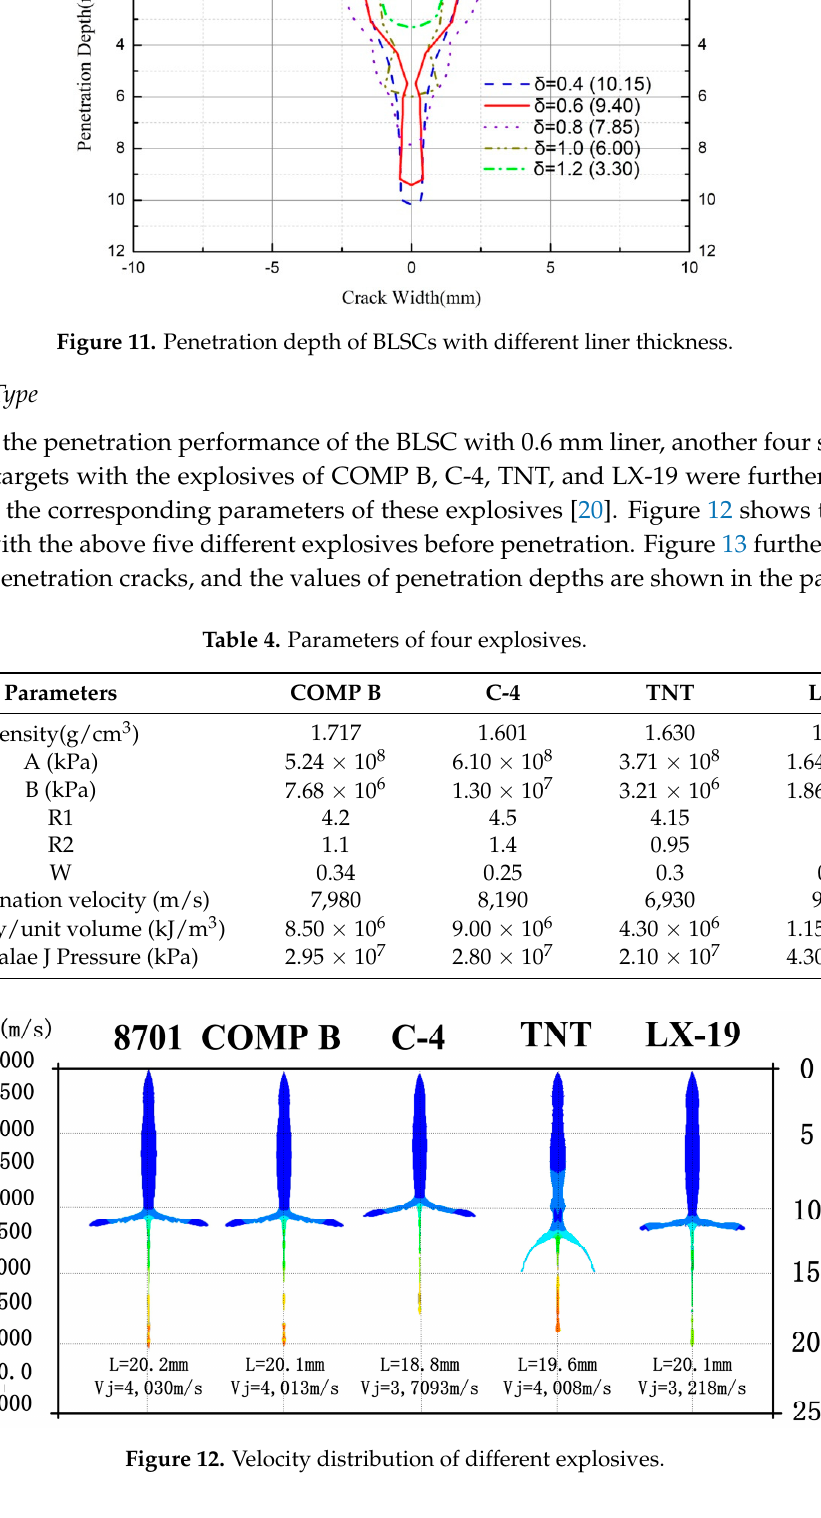
Figure 12. Velocity distribution of different explosives.